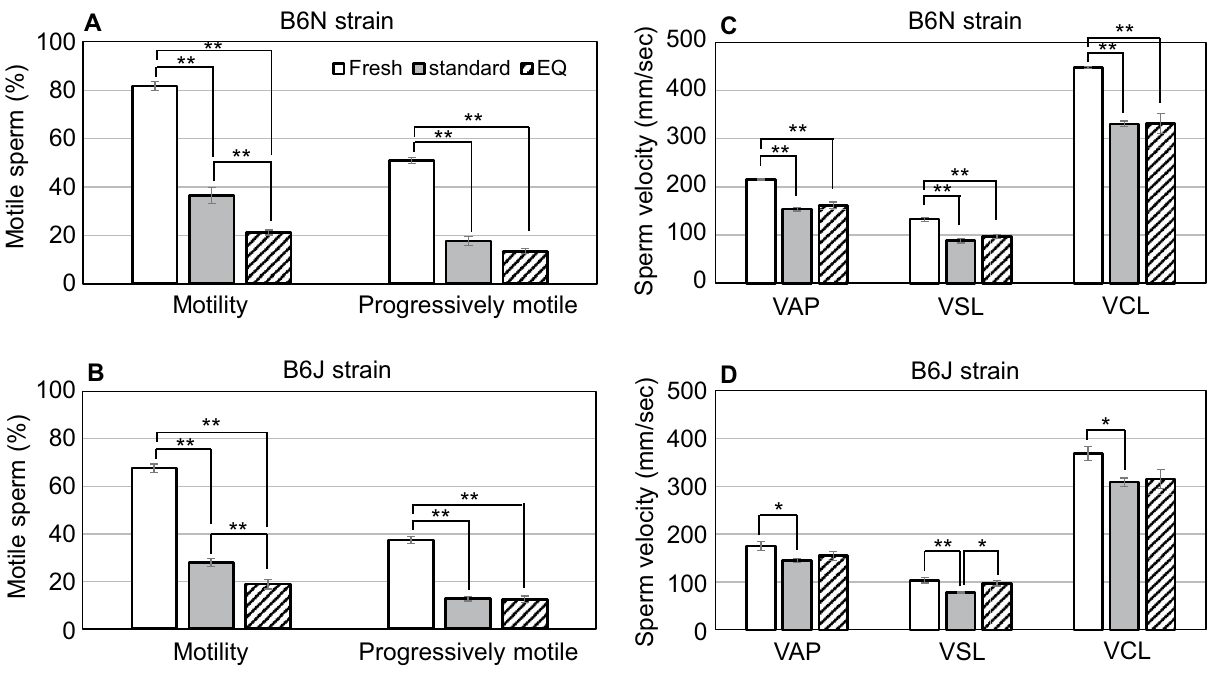
Figure 4. Results of sperm kinetic analysis. The motility rate, progressive motility rate and three kinds of velocity parameters were measured using frozen–thawed spermatozoa from B6N (n = 6) ( A,C ) and B6J (n = 7) ( B,D ) mouse strains. The asterisks indicate significant differences between groups ( P < 0.05 by Tukey–Kramer test).